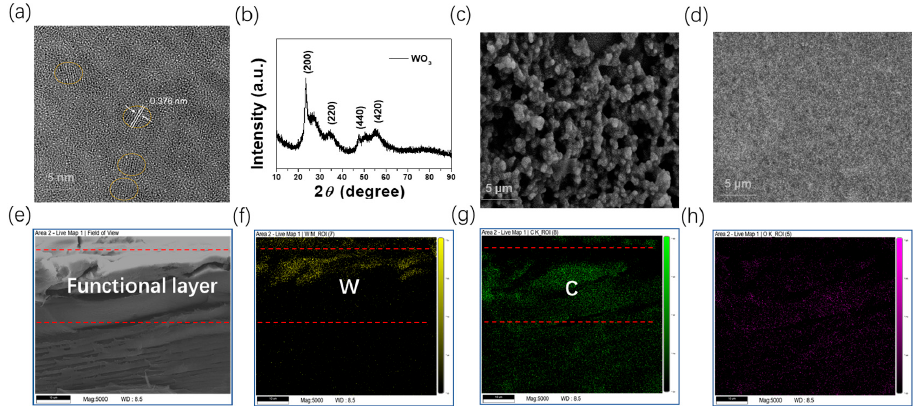
Figure 2 . The characterization of material and electrode micromorphology. ( a ) TEM image of WO 3 nanocrystals; ( b ) XRD diagram of WO 3 nanocrystals; ( c ) SEM image of the unmodified carbon electrode; ( d ) SEM image of WO 3 -modified electrode; ( e ) Cross-sectional SEM image of the modified electrode; ( f – h ) The W-element ( f ), C-element ( g ), and O-element ( h ) distribution mapping of the electrode’s cross-section.